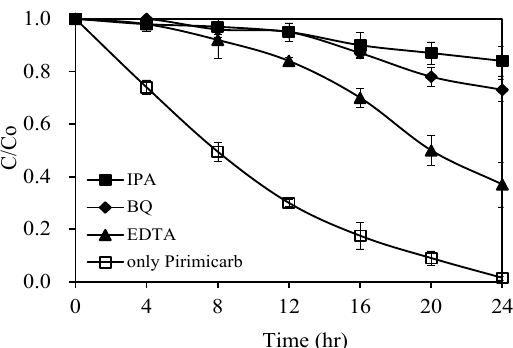
Figure 10. Photocatalytic degradation of pirimicarb with 1.0 wt% Pt / AgInS 2 photocatalyst in the absence and presence of scavengers (isopropanol (IPA), ethylenediaminetetraacetic acid (EDTA), and benzoquinone (BQ)) under visible-light irradiation. Experimental conditions: pirimicarb concentration 10 mg L − 1 ; 1.0 wt% Pt / AgInS 2 concentration 1.0 g L − 1 ; scavenger concentration 1 × 10 − 3 M; pH 5. Error bars represent the standard deviations of duplicate runs.